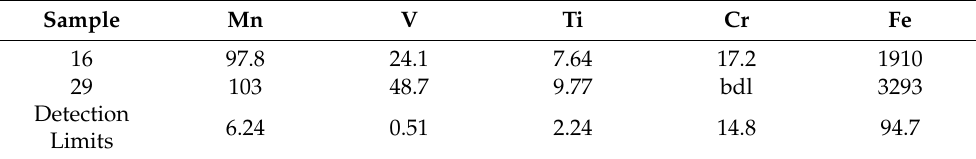
Table 3. Contents of trace elements in samples with blue-white fluorescence under LWUV (ppmw).